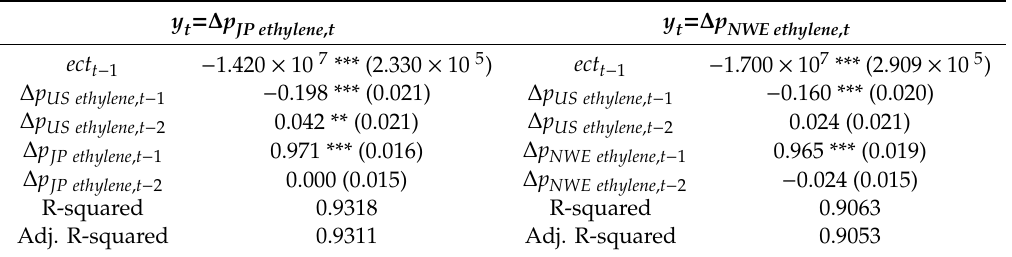
Table 9. Estimated results of error correction model including time-varying cointegration